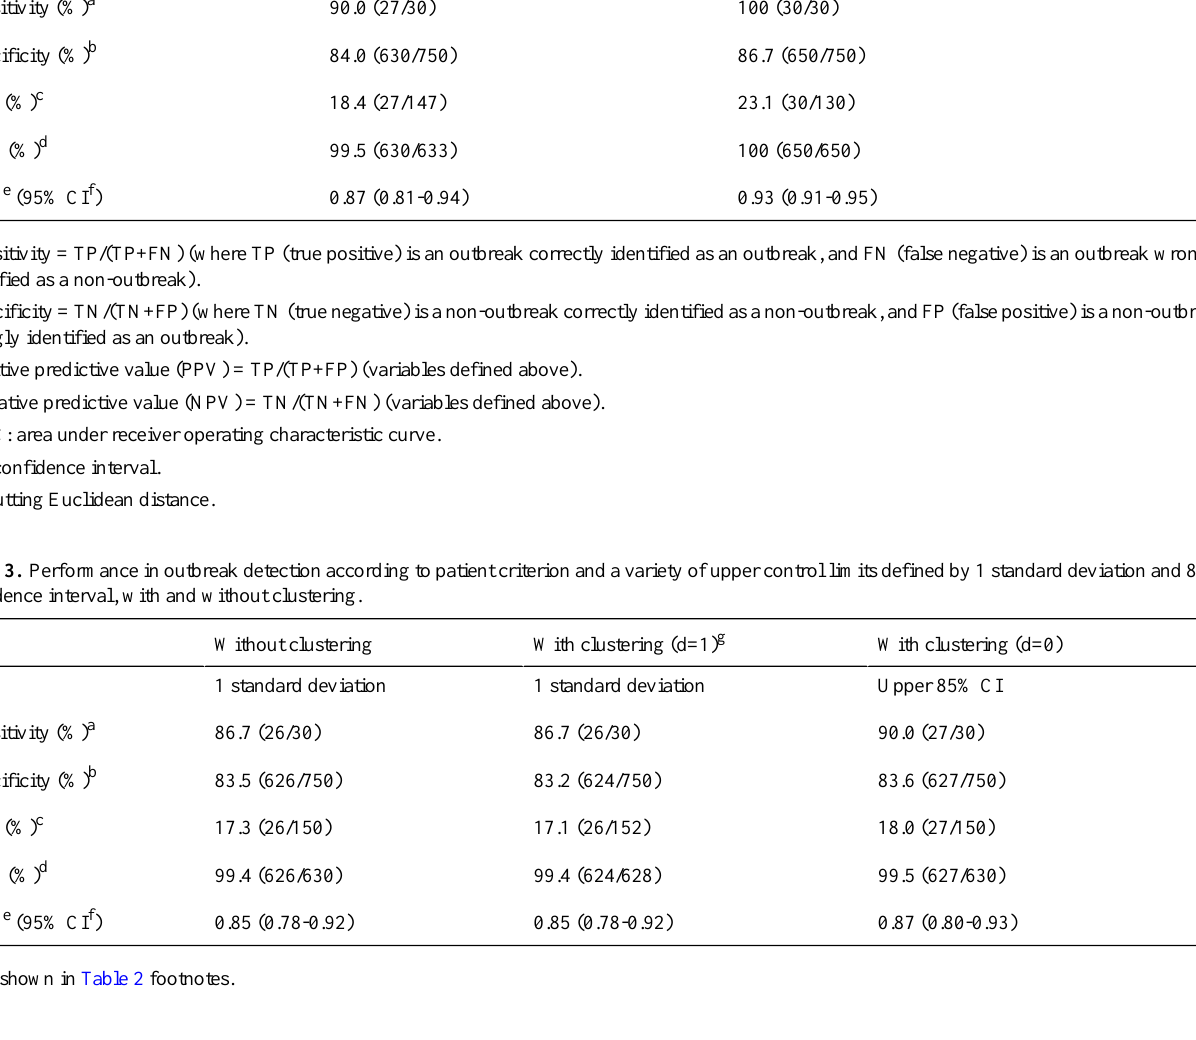
Table 4. Performance in outbreak detection according to incident patient criterion and a variety of upper control limits defined by 1 standard deviation and 90% confidence interval, with and without